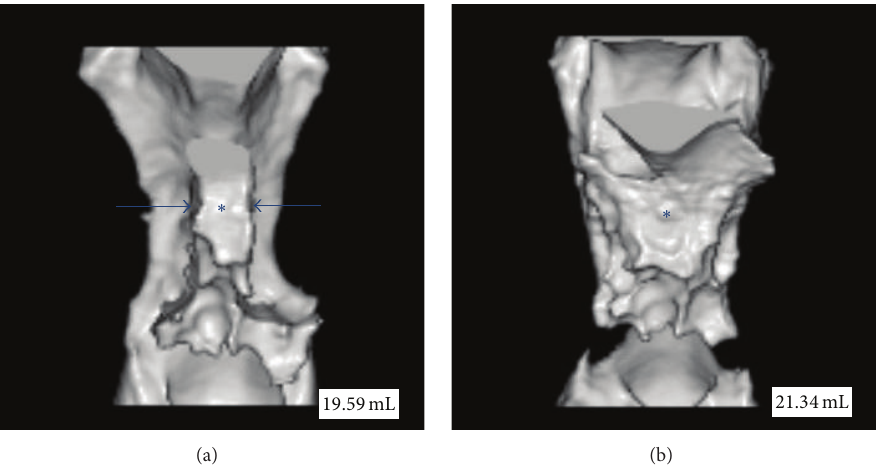
Figure 2: Anterior-view three-dimensional computed tomography images from patient 1. (a) Bilateral large tonsils impressed on the glossopharyngeal airway from both sides (blue arrows) before uvulopalatopharyngoplasty (UPPP). The gap between two arrows shows the airway (asterisk). (b) The airway was enlarged after UPPP. Nevertheless, the change in the volume of the airway (indicated by the number) was negligible.